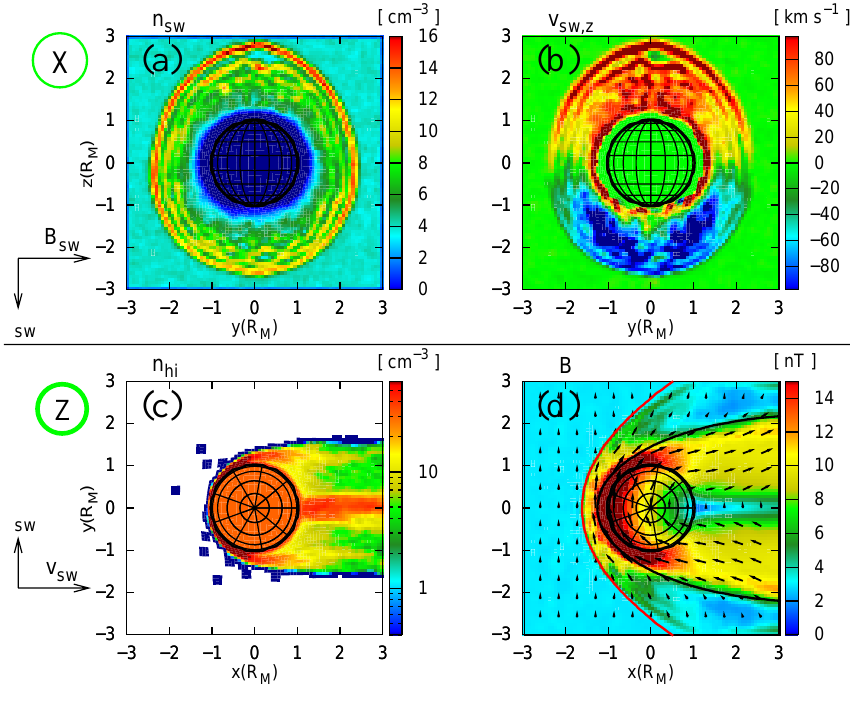
Fig. 17. Comparison of the simulated boundaries with Mars Global Surveyor data. (a) solar wind density, (b) z - component of the solar wind veloc- ity in the plane x = 0, (c) heavy ion density and (d) magnetic field in the plane z = 0. The red (BS) and black (MPB) solid lines in panel (d) represent a fit with Eq. (10) obtained from the MGS data, which is taken from Vignes et al. (2000). This good agreement be- tween simulation and observation was achieved for a value of T e , h = 3000K, which is about the measured temper- ature of the dominant O + component in the Martian ionosphere (Hanson and Mantas,